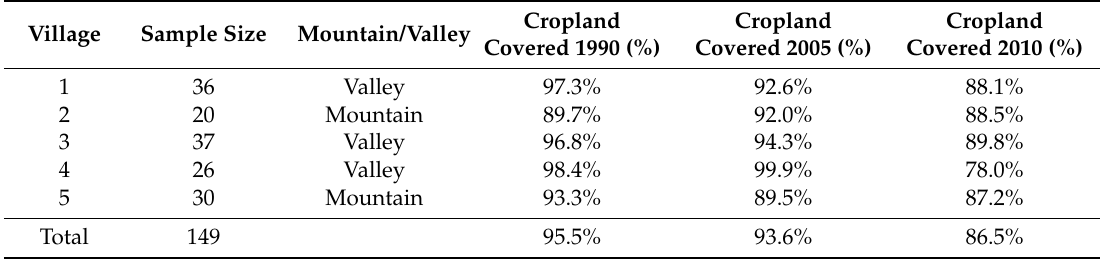
Table 1. Villages including sample and percentage of coverage by crops